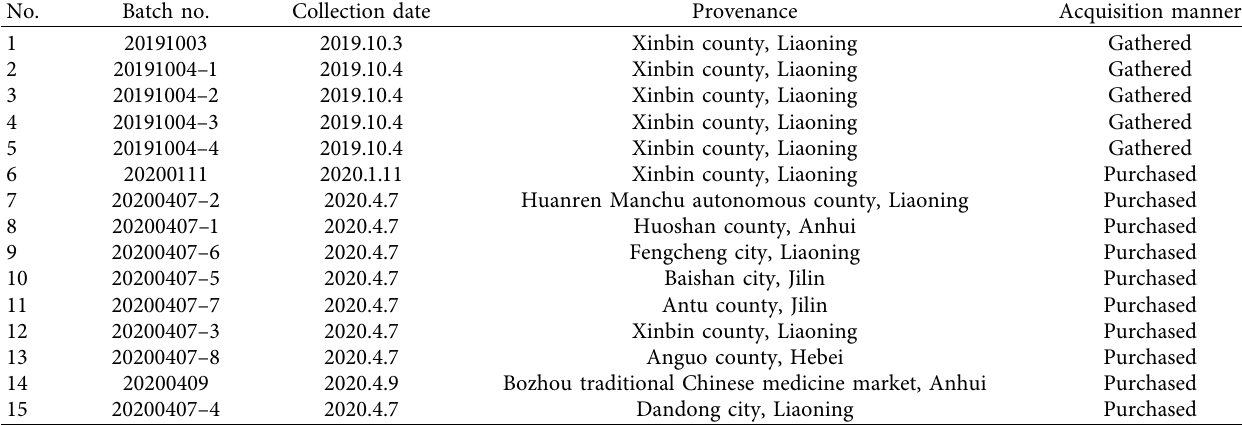
Table 1: List of batch no., collection date, provenance, and acquisition manner for plant samples investigated. No. Batch no.